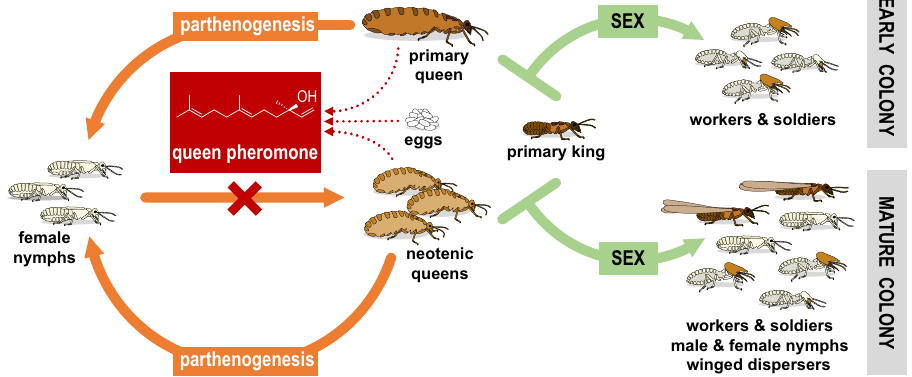
Fig. 7 Proposed scheme of genetic and pheromonal regulation of the AQS breeding system in E. neotenicus . Based on the present results and our previous observations on the chemical ecology and breeding system of the species 23,39,44,58